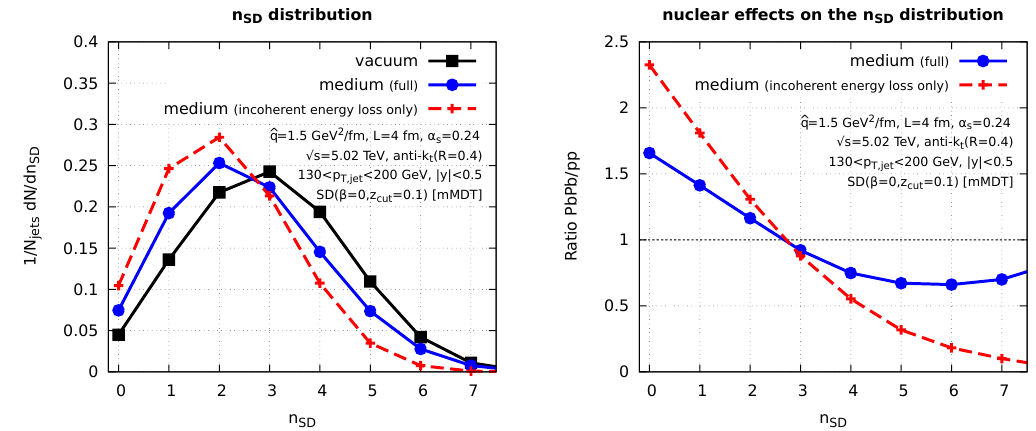
Figure 22 . n SD distributions emerging from our Monte Carlo simulations. Left: the distributions themselves, for the vacuum shower, for the full in-medium parton shower, and also for the case where the MIEs contribute only to the energy loss (but not directly to SD). Right: the medium/vacuum